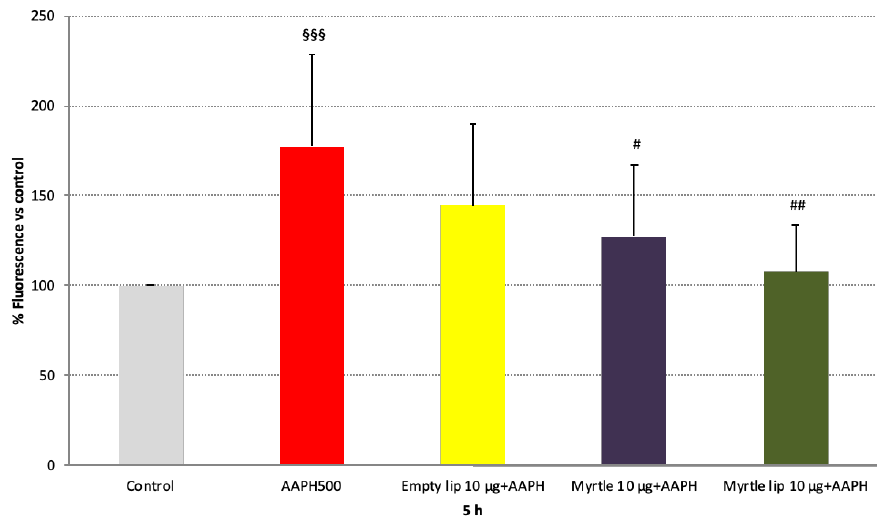
Figure 5. Anti-ROS effect of empty liposomes, myrtle solution, and myrtle liposomes on 3T3-L1 cells stressed with AAPH (500 μM). Data are expressed as means ± SD; n = 3. §§§ p < 0.005 vs. control (i.e., cells without AAPH); # p < 0.05 vs. 500 μM AAPH; ## p < 0.01 vs. 500 μM AAPH.